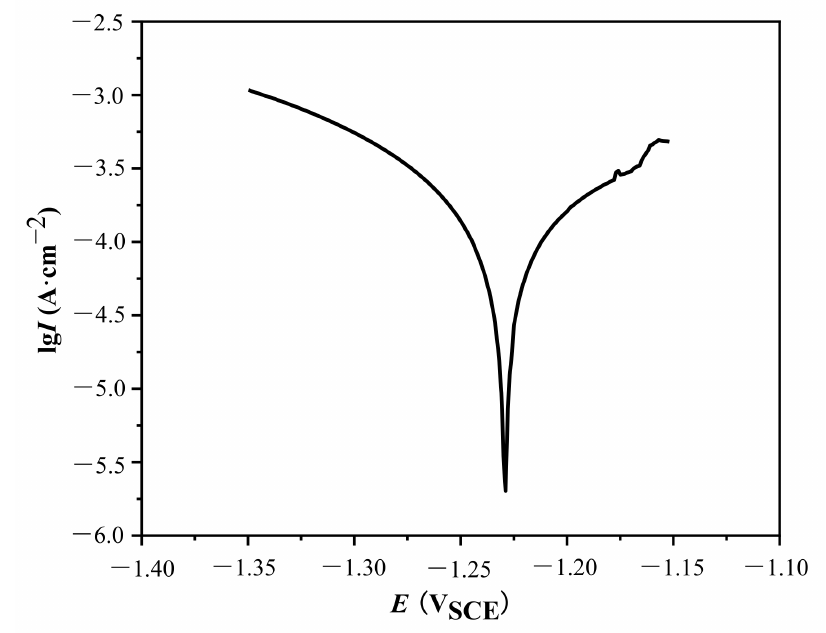
Figure 8. Potentiodynamic polarization curves of TC4 alloy in the artificial